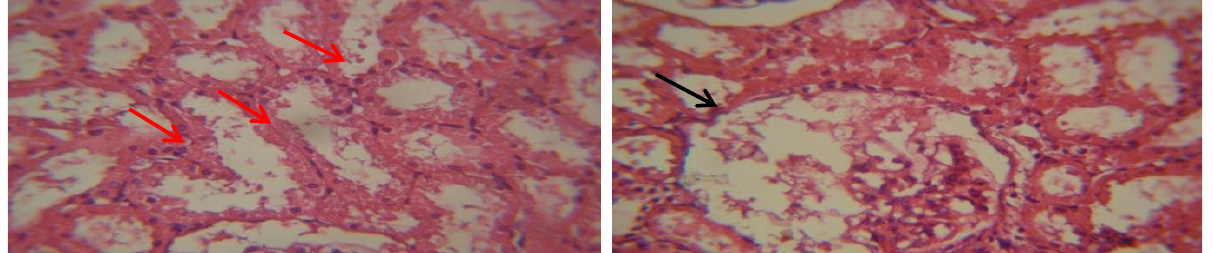
Figure 3. Histopathological section of kidney in gentamycin treated group shows glomerular necrosis (black arrow) and epithelial necrosis of proximal renal tubules in the cortex (red arrow). H&E 100 × and 500 ×